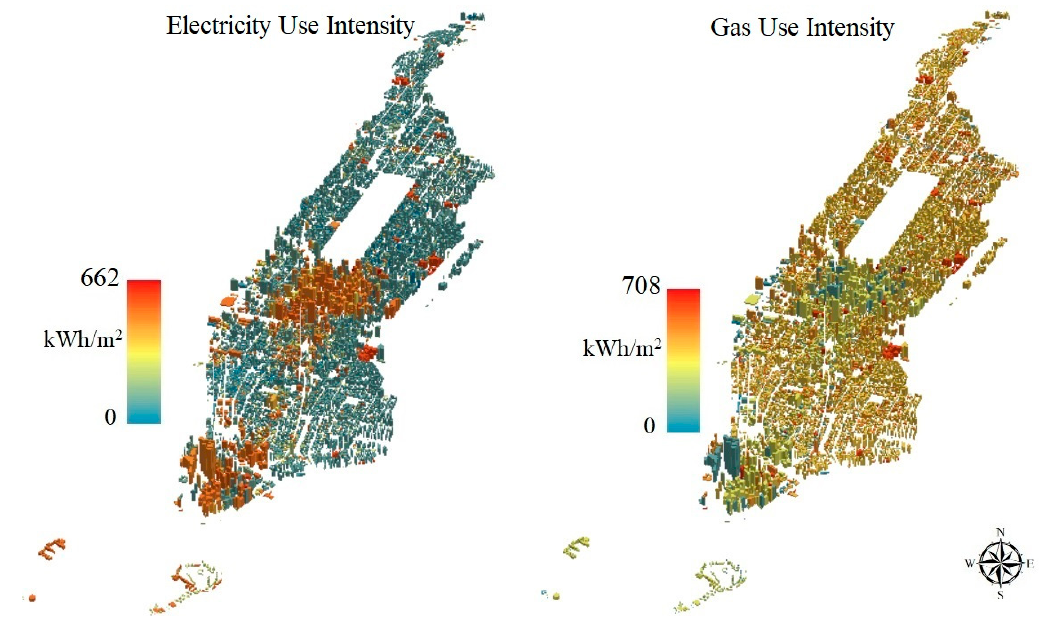
Figure 7. Modeled annual building electricity- and gas-use intensity in Manhattan, NYC, in 2012.